Question: Provide a one-line summary of what is displayed.
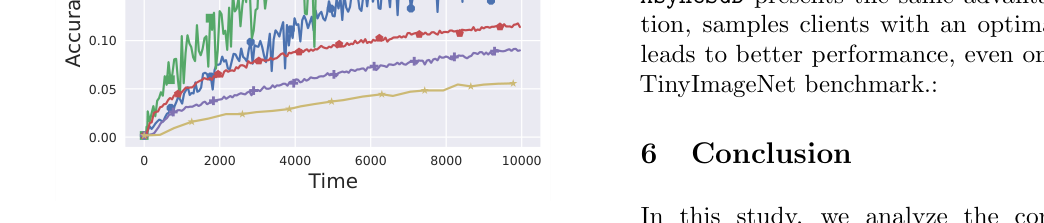
Answer: Test accuracy on TinyImageNet dataset with n = 100 total nodes.